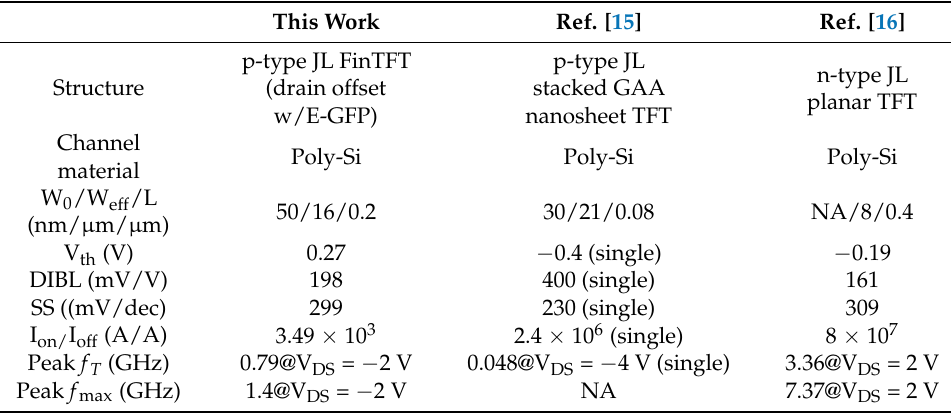
Table 4. Parameters in comparison with other